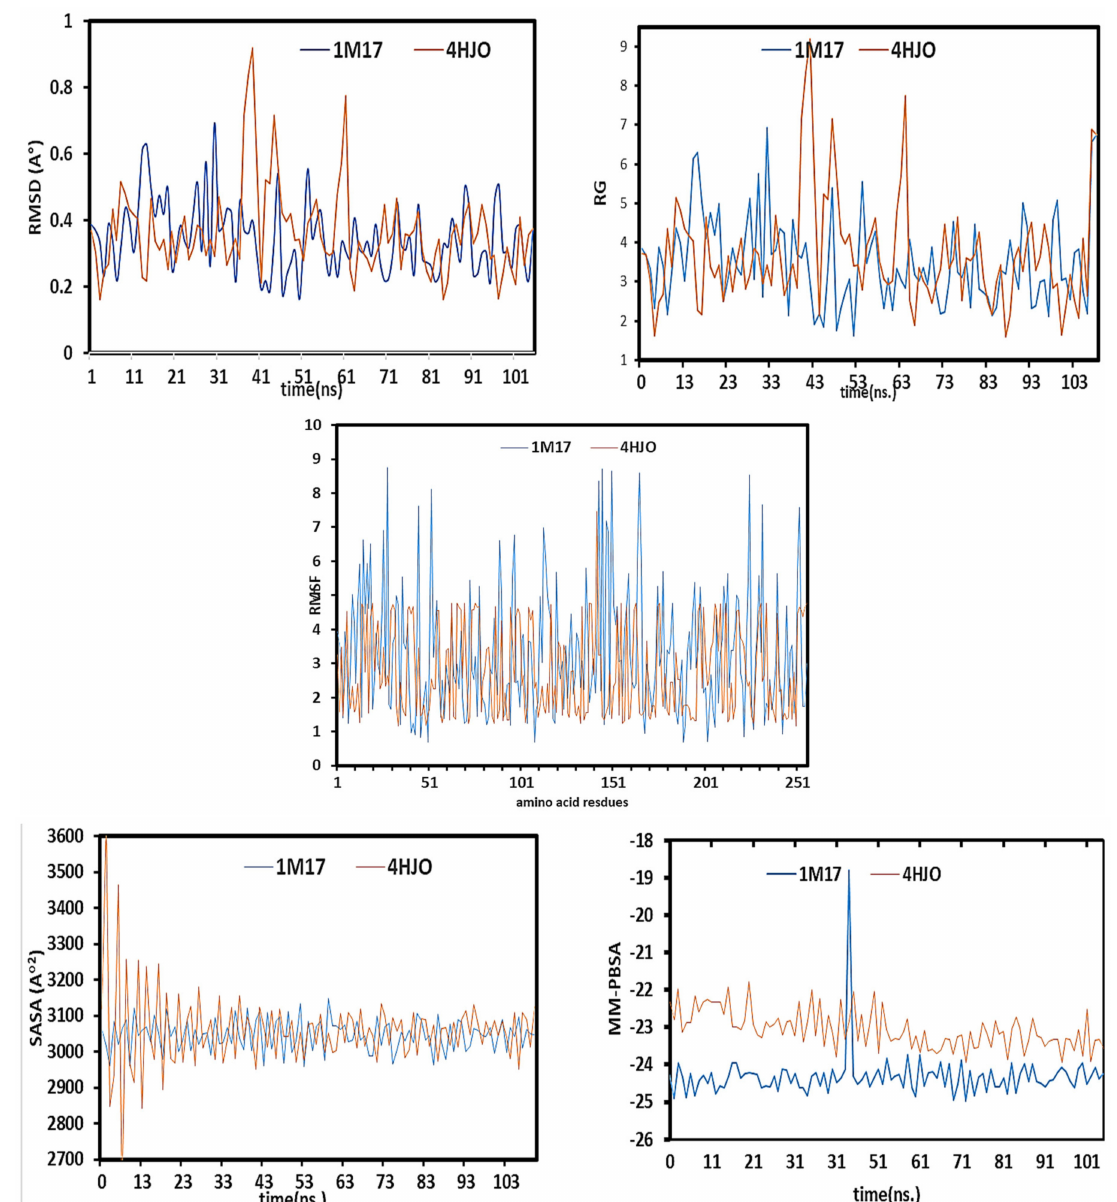
Figure 8. The molecular dynamic simulation for compound 4 at 100 − ns simulation time. As a result, the studied complexes had a RMSD less than 2.5 during the simulation, defining the complexes’ stable comparative nature. The analyzed “RG, radius-gyration” along the studied trajectories showed the flexibility and mobility degree for the 1M17 and 4HJO complexes. The RG steady degree for the studied complexes appeared at 33 ns and 43 ns for 1M17 and 4HJO, respectively. The “RMSF, root-means-square-fluctuations” were also explored to investigate the flexibility of the residues of amino acids (Figure 9). The low RMSF <2.5 Å for 1M17 and 4HJO showed a high rigid degree for their complexes, while the increasing RMSF <6 Å for the BF-3 complex showed the relative flexibility degree of the backbone of the amino acid